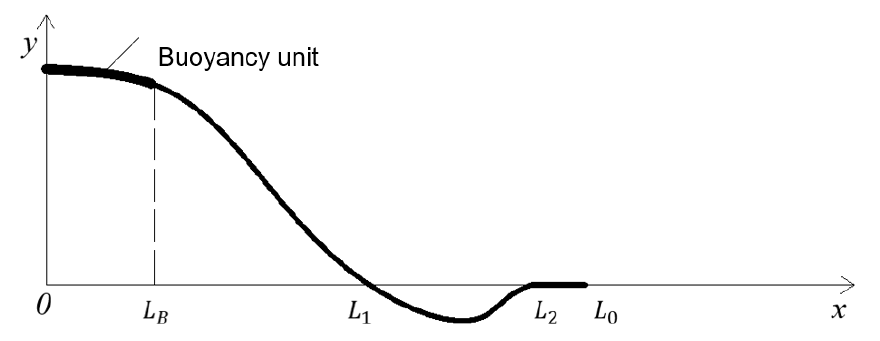
Figure 11. Force diagram of SDB.